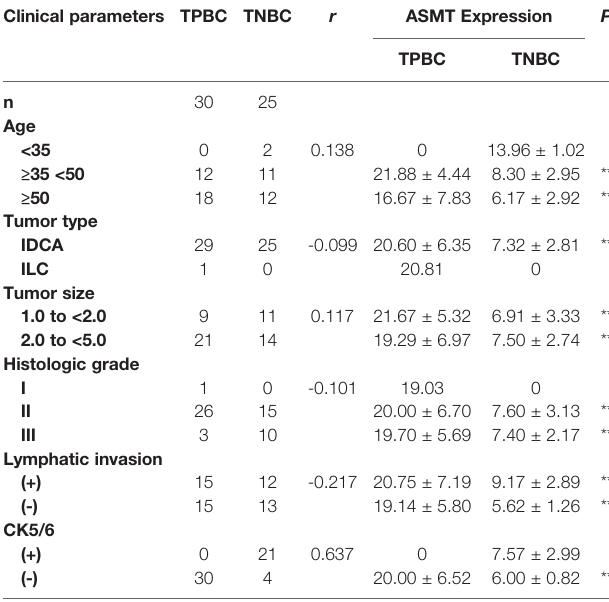
r: Correlation Coef fi cients. ThecorrelationanalysiswasperformedbySpearmancorrelationtest,**p<0.01.Thedata were presented as mean ±